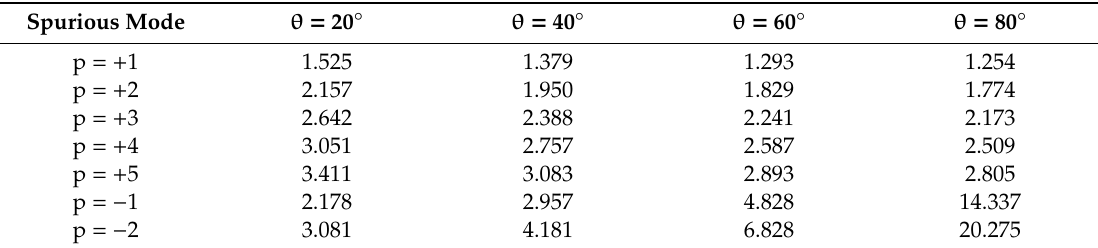
Table 1. Frequencies in hertz where spurious waves transit from evanescent to progressive. Spurious